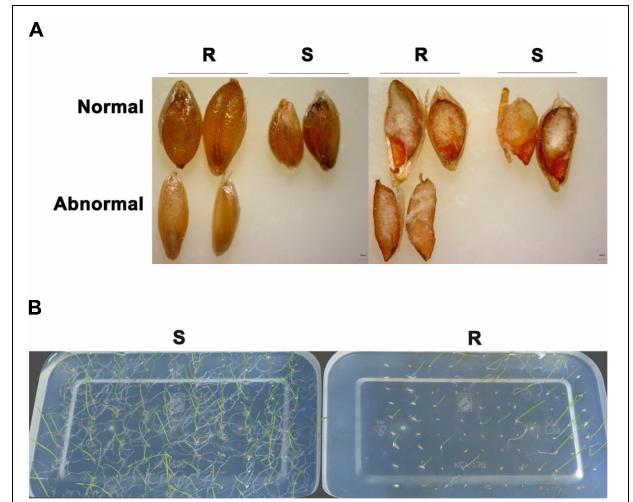
FIGURE 4 | Comparison of seed vigor and the germination rate between resistant (R) and susceptible (S) of Polypogon fugax . (A) Seed appearance (left) and the seed embryo activity test by the TTC method (right) in R and S plants. (B) Seed germination (23 day) of R and S plants on 0.6% agar at 15 ◦ C.